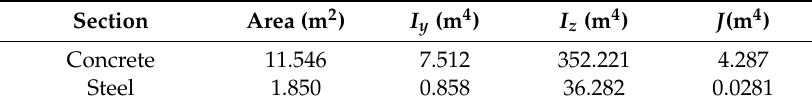
Table 1. Sectional properties of the bridge deck.